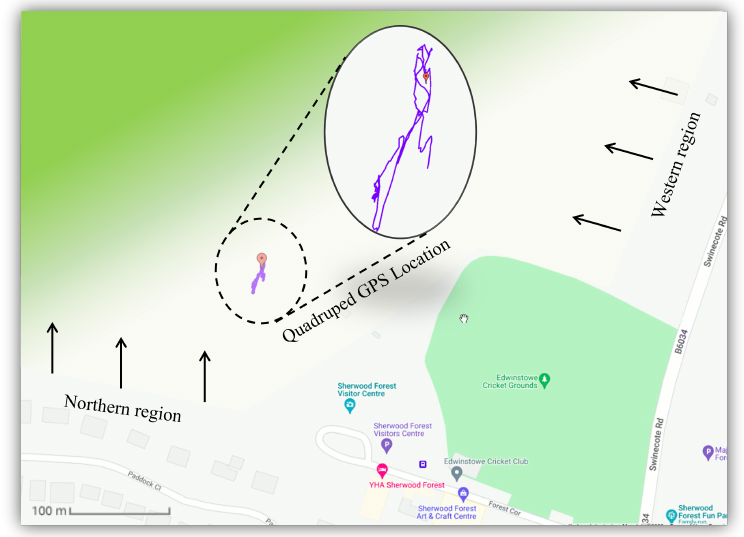
Figure 9. Google Maps demonstrating the tracked trajectory of the quadruped robot in real-time.